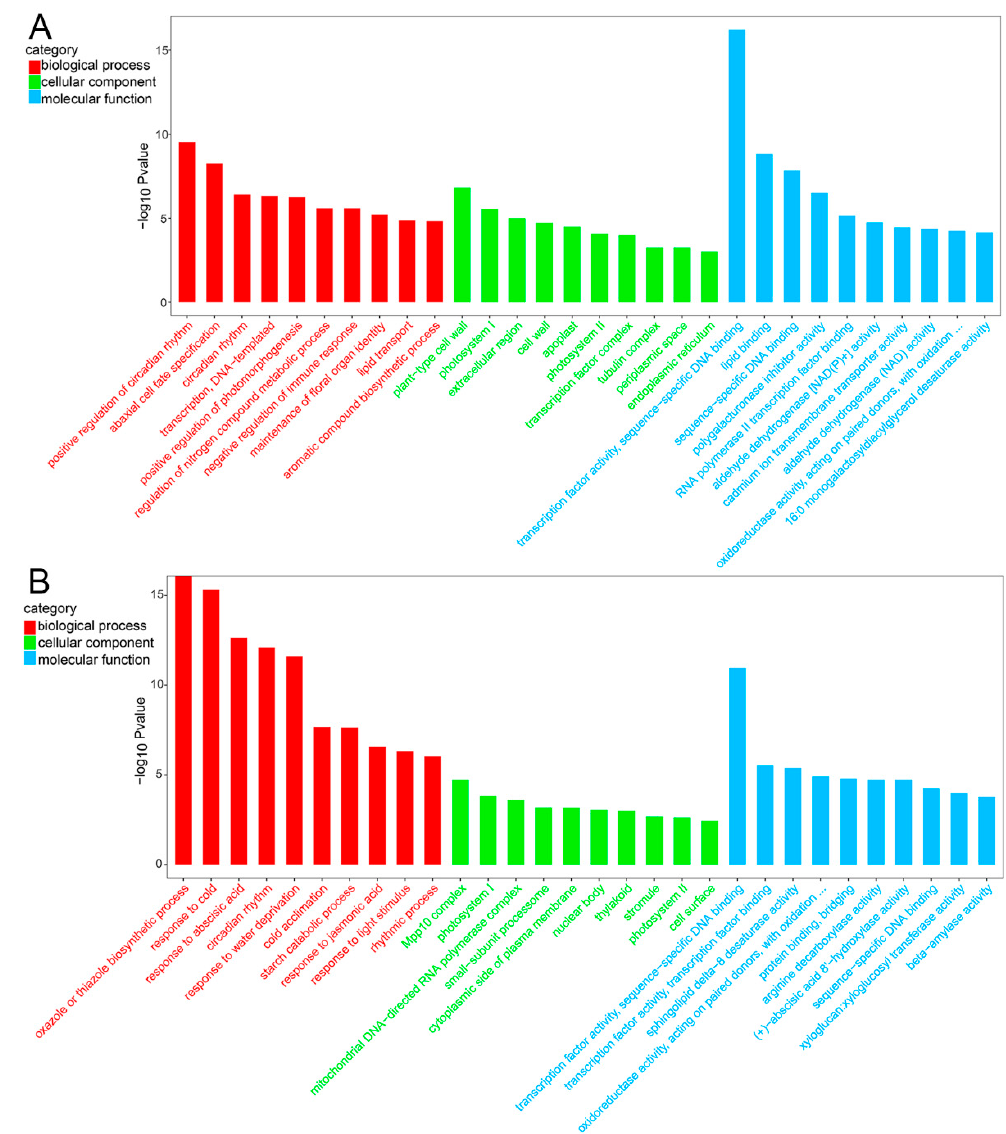
Figure 4. Visualization of GO enrichment terms related to cold response. Functional classification of